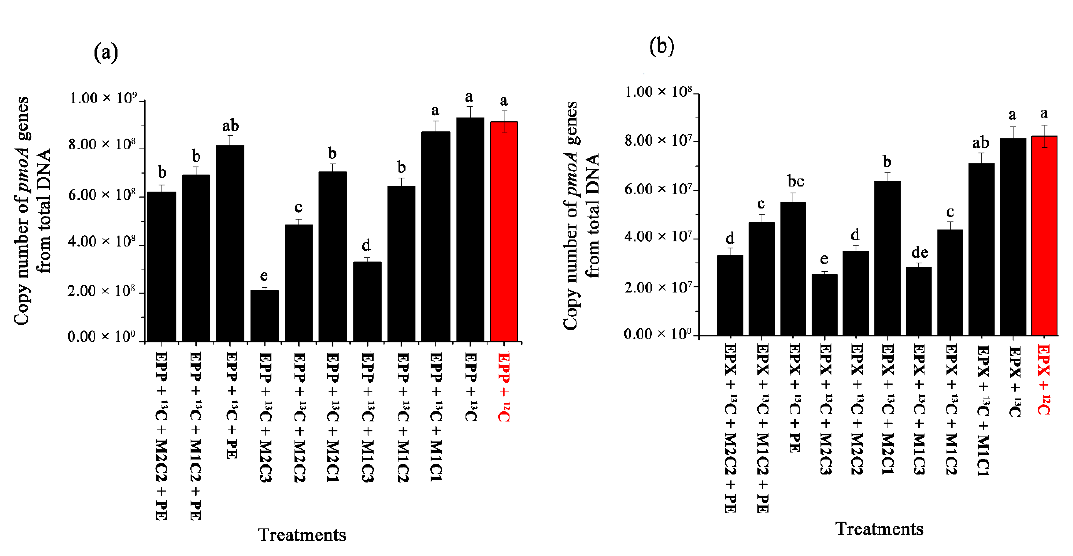
Figure 7. Relative abundance of pmoA genes from total DNA—copy numbers of pmoA genes in ( a ) epiphyton and ( b ) epixylon from total DNA. The data in a column with a different letter differ significantly at Duncan’s significance level 0.05.